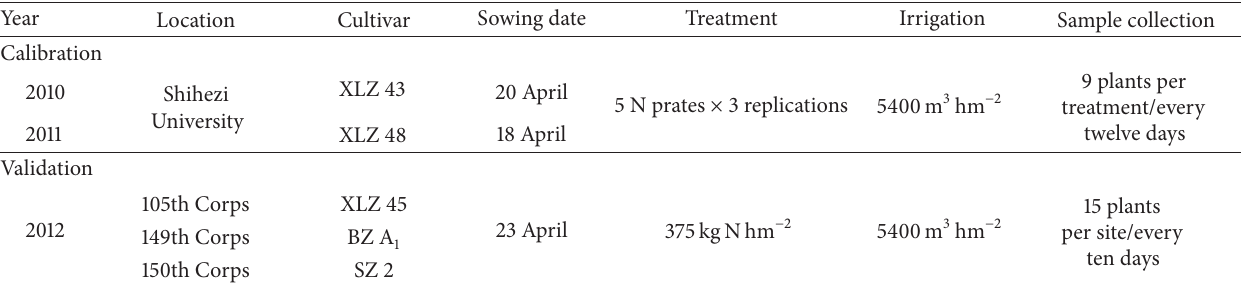
Figure 2: (a) Image of the cotton canopy taken with a digital camera; (b) the proportion of green pixels in the image; (c) the segmentation of the cotton canopy into four parts. The canopy cover in both (b) and (c) was calculated to be 0.6119. Table 2: Description of experiments for the calibration (experiment 1) and validation (experimentation) of the models. Year Location Cultivar Sowing date Treatment Irrigation Sample collection